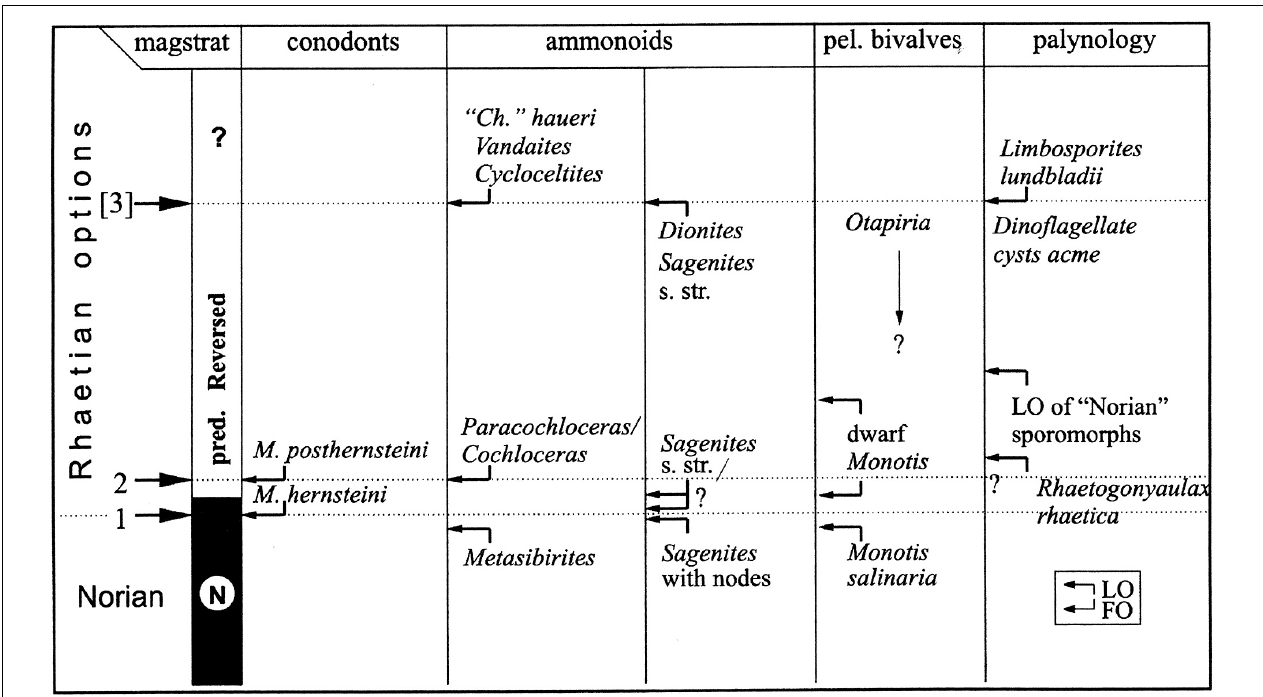
FIGURE 6 | The signals associated with the proposed GSSP of the base of the Rhaetian Stage at Steinbergkogel in Austria (after Krystyn et al., 2007). Note that FO, first occurrence and LO, last occurrence.